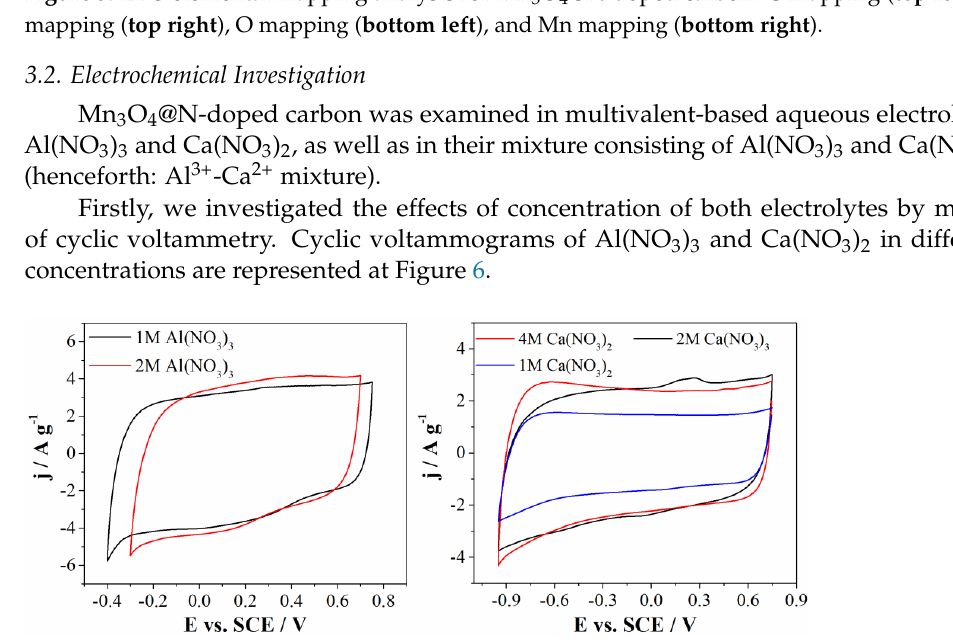
Figure 6. CVs of Mn 3 O 4 @N-doped carbon electrode in 1M and 2M Al(NO 3 ) 3 ( left ) and 1M, 2M, and 4M Ca(NO 3 ) 2 ( right ), recorded at 20 mV s −1